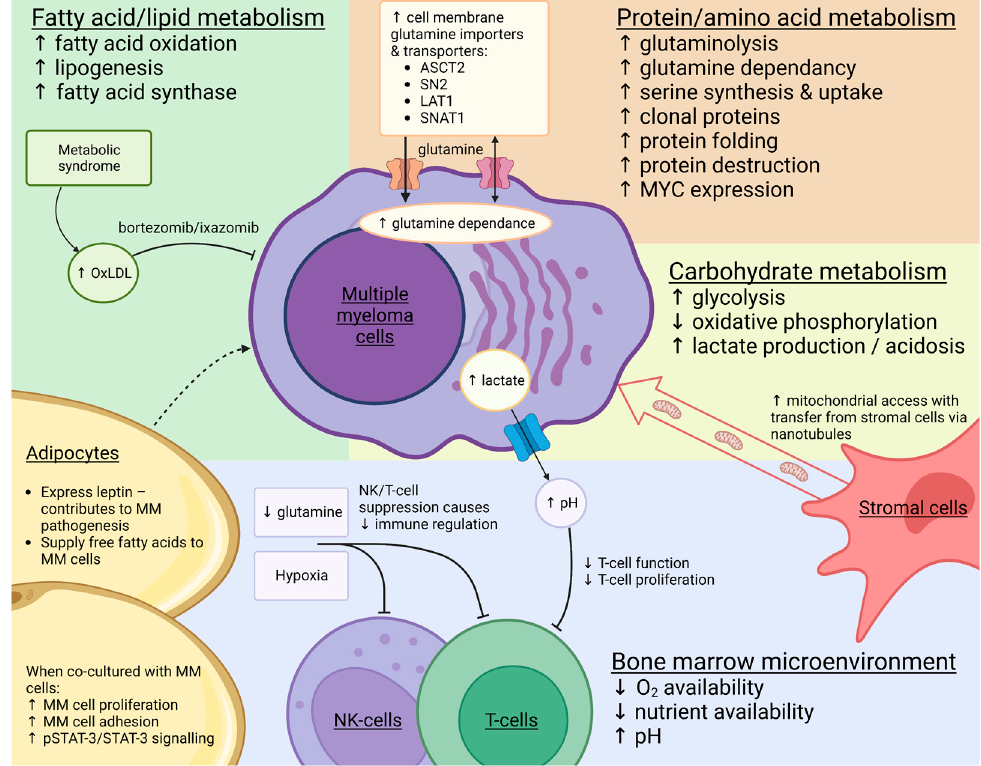
Figure 1. Summary of the main metabolic changes that develop in multiple myeloma (MM) and how systemic metabolic conditions and cells in the bone marrow microenvironment interact with and influence MM cell metabolism. ASCT2: alanine/serine/cysteine-preferring transporter 2; LAT1: L-type/large neutral amino acid transporter 1; OxLDL: oxidatively modified low-density lipoprotein; SN2: system N transporter; SNAT1: sodium-coupled neutral amino acid transporter 1.